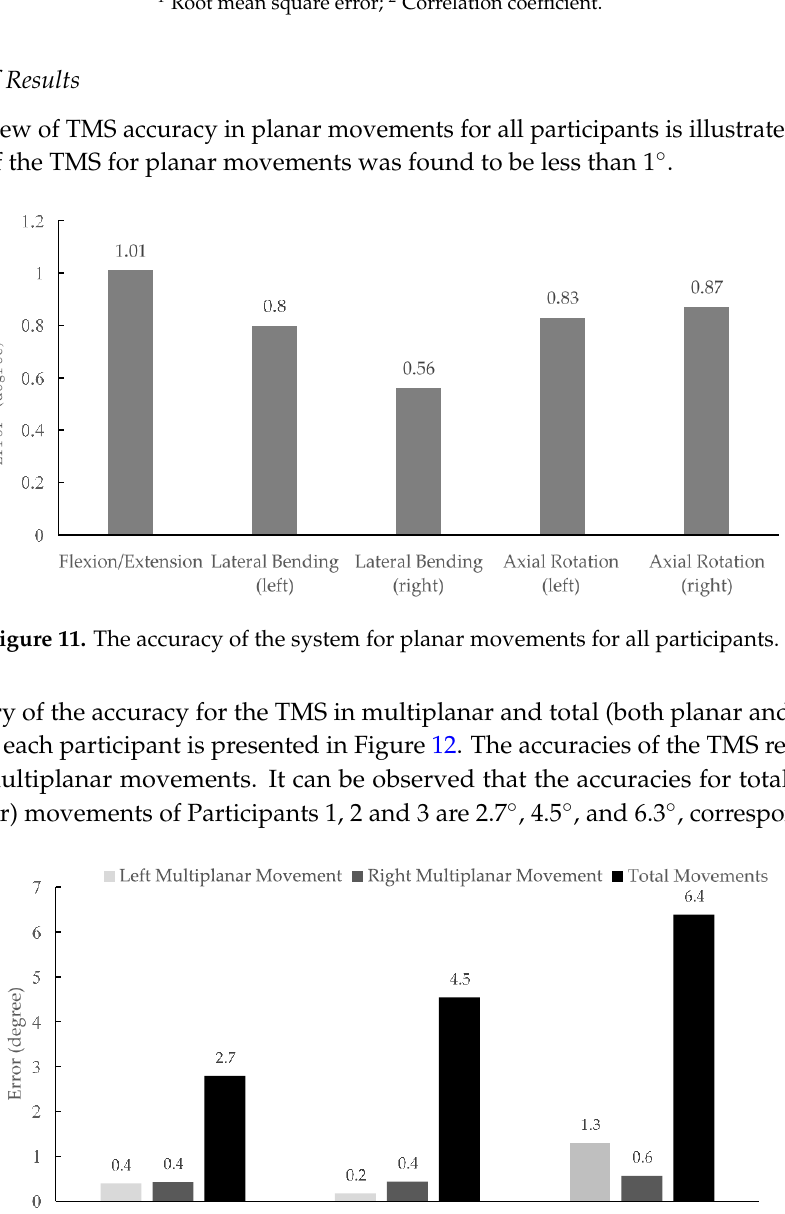
Figure 12. The accuracy of the TMS for multiplanar and total (planar and multiplanar) movements.